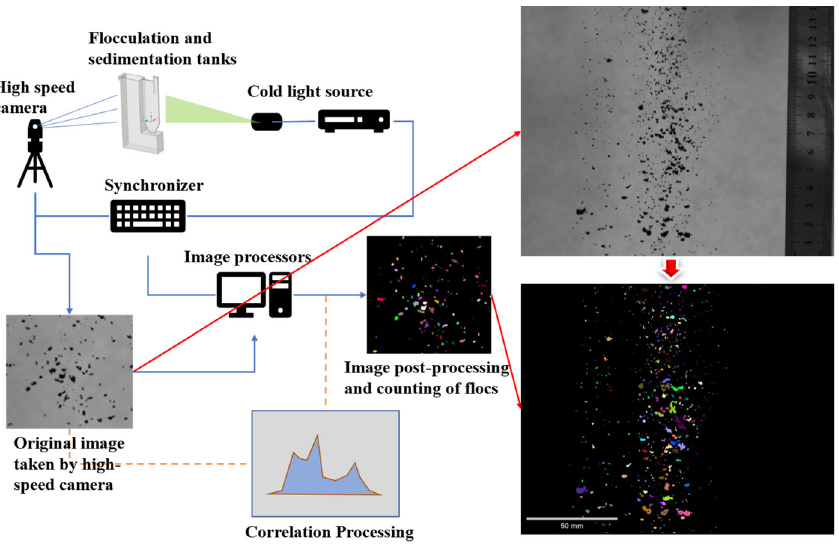
Figure 7. Calibration of the volume fraction parameter of each equivalent particle size floc among the total flocs (Where the red arrows indicate zooming in on the picture and displaying the panorama; the blue arrows indicate signalling; and the dashed lines indicate the operation process.).